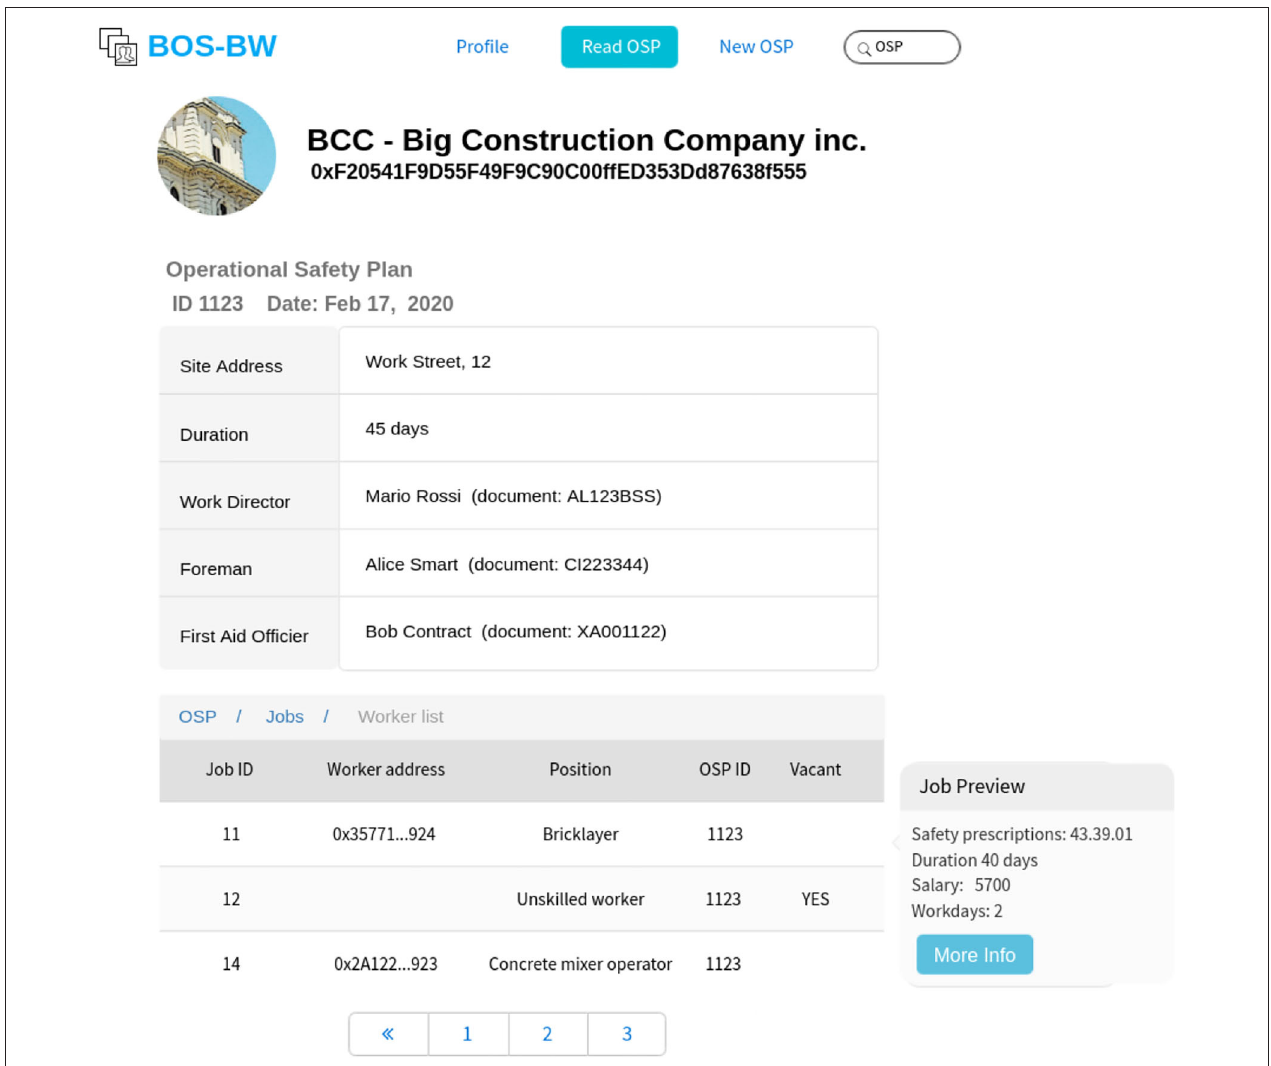
FIGURE 10 | A User Interface screen, which provides the summary of the OSP ID 1123 and the list of workers employed in the construction